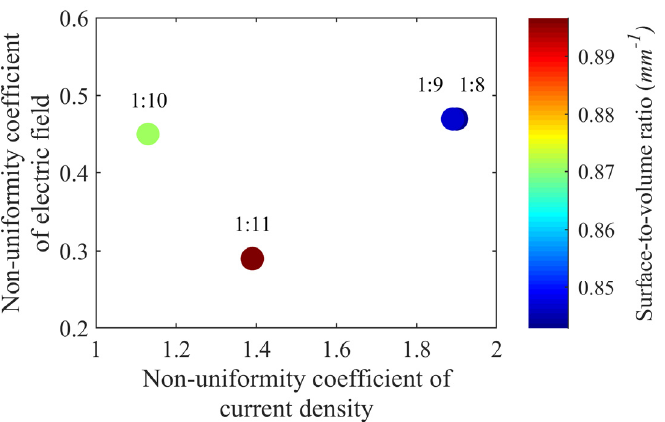
Figure 4. Comparison of model-predicted nonuniformity coefficients of current density and electric fields for electrodes with different weight ratio percentages. The color bar represents normalized surface-to-volume ratio.